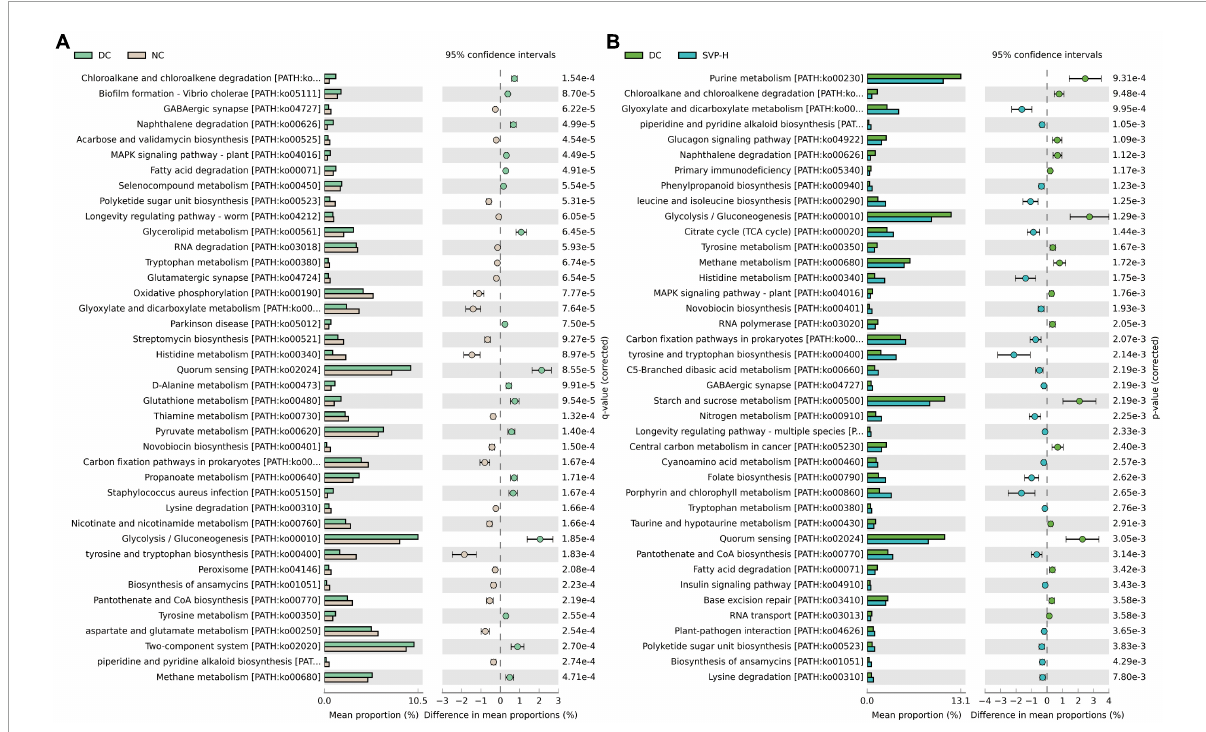
FIGURE7 The differences of predicted function of the intestinal microbiota based on PICRUSt2 with Welch’s t -test and the p -value corrected by Benjamini–Hochberg method. (A) DC group versus NC group; (B) DC group versus SVP-H group. Corrected p < 0.05, confidence intervals = 95%, top 40 functional modules are presented according to the order of corrected p